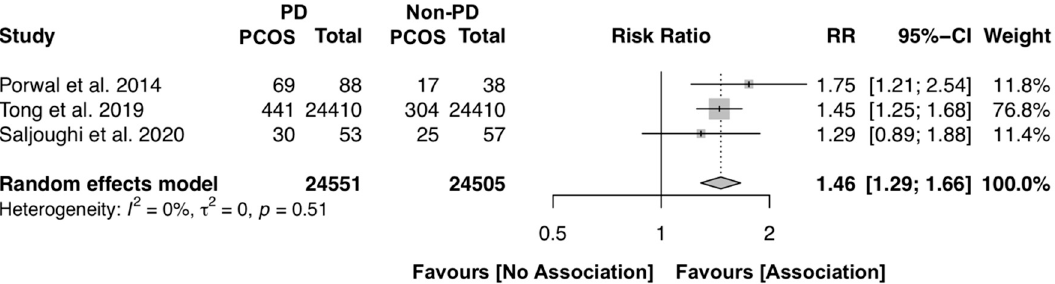
Figure 3. Forest plot of risk ratio of PD female individuals to have PCOS (p-value < 0.0001). Mean effect size estimates have been calculated with 95% confidence intervals and are shown in the figure. The size of the squares is proportionate to the study sample size, continuous horizontal lines and diamonds width represents 95% confidence interval. Diamond and the vertical dotted line represent the overall pooled estimate.